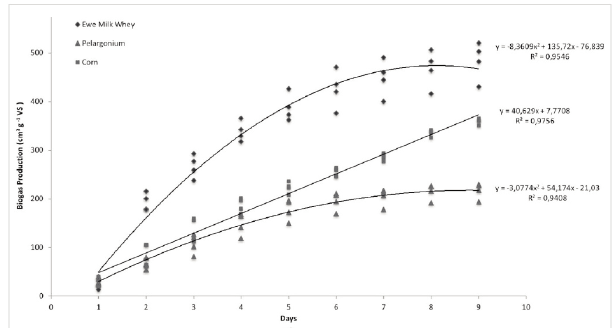
Fig. 5 - Regression (linear and polynomial) of ewe milk whey, corn silage and pelargonium residues.